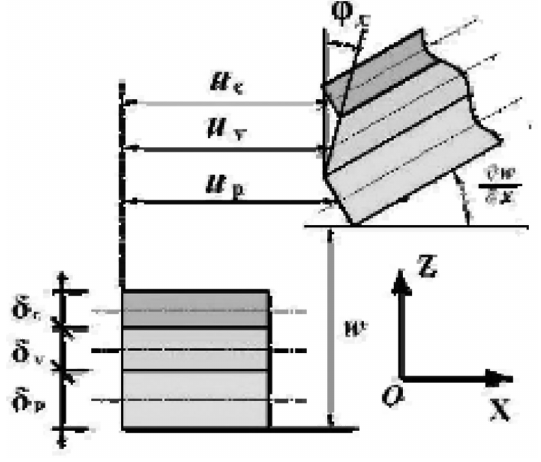
Fig. 2. Geometry and deformation of the plate with CLD